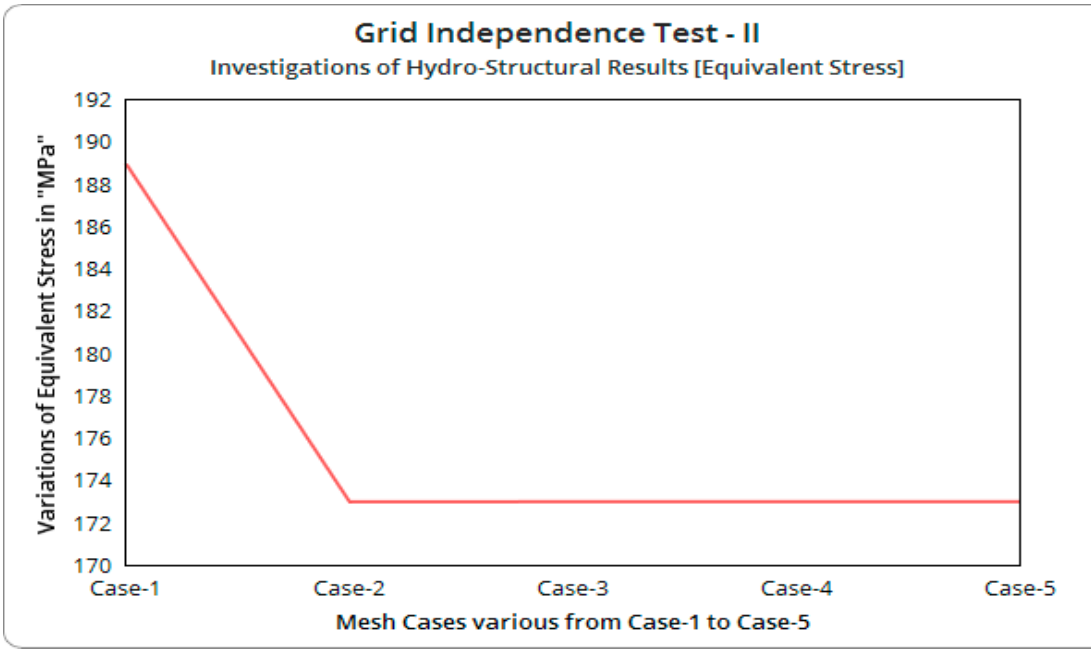
Figure 14. Grid Convergence Test-2. Table 13. Comparative information of all the mesh cases.